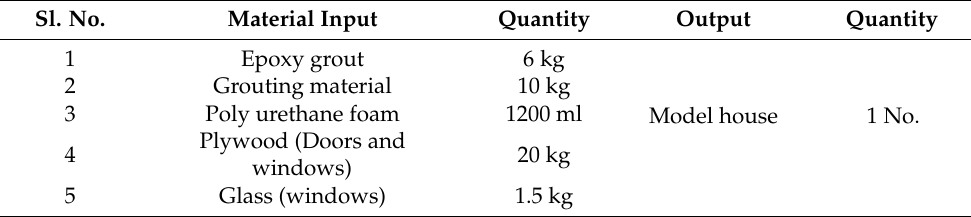
Table 9. Inventory details of Phase F—Erection of prefabricated elements. Sl. No.